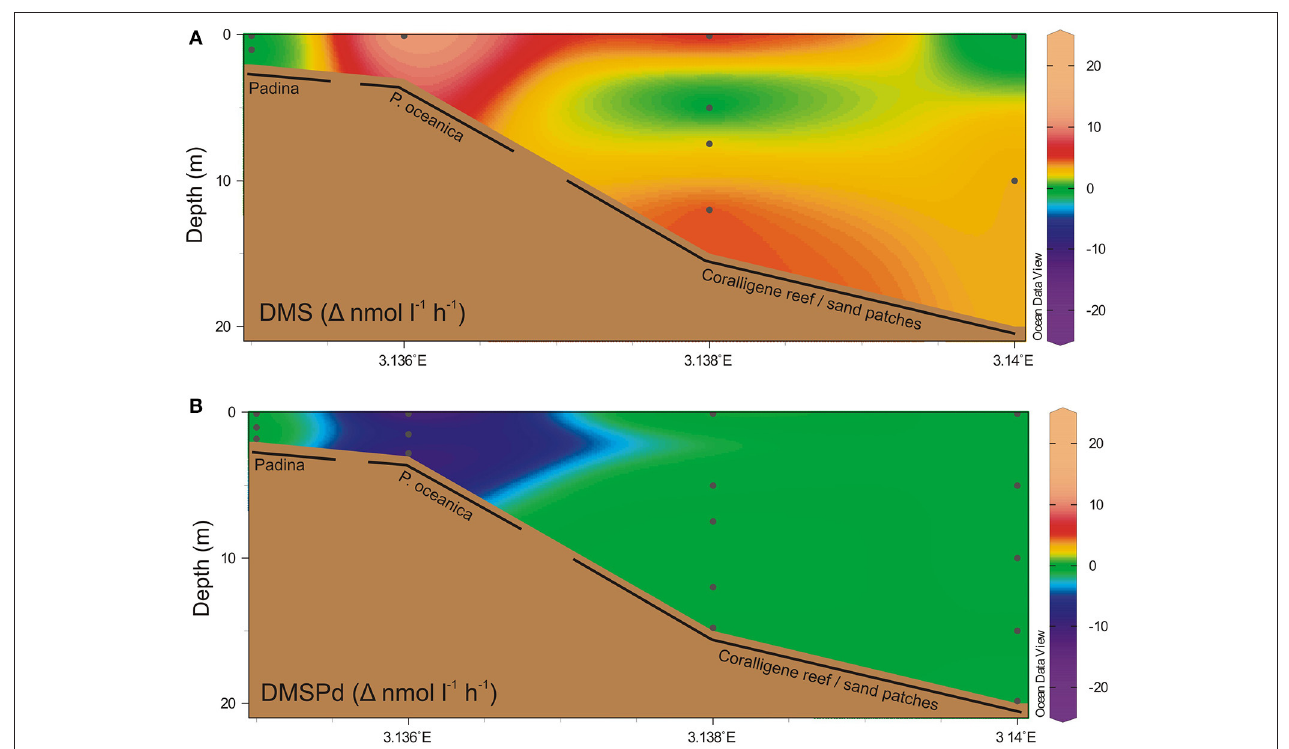
FIGURE 3 | Temporal net change in water column dimethylated sulfur. Net change in water column concentrations over time ( 1 nmol l − 1 h − 1 ) of (A) DMS and (B) dissolved DMSP. Black dots indicate discrete sampling locations. Positive change indicates a net increase in